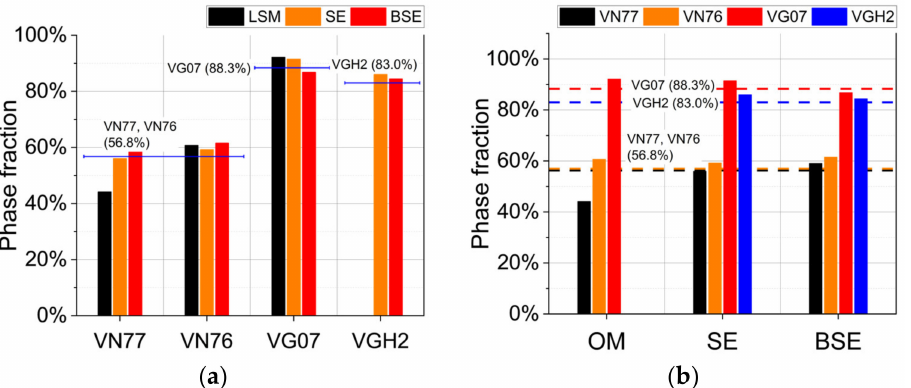
Figure 7. Results obtained by the area analysis (AA) of: ( a ) the phase fraction vs. cemented carbide grades, and ( b ) the phase fraction vs. image acquisition. Table 13. WC grain size obtained by the